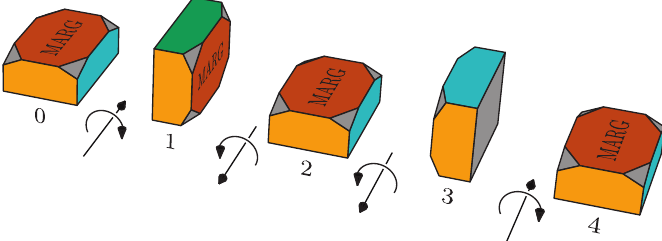
Figure 4. Schematic representation of turn maneuver in one